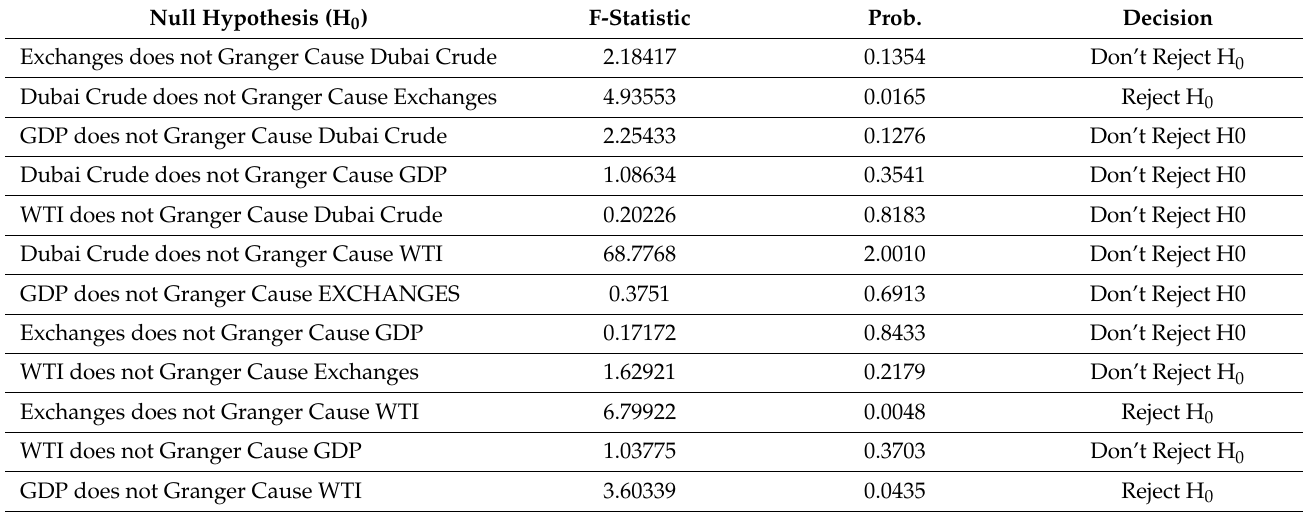
Table 5. Results of Granger Causality for the Returns of Crude Oil Price Shocks on GDP per Capita, and Exchange Rate in India during the period from 1990 to